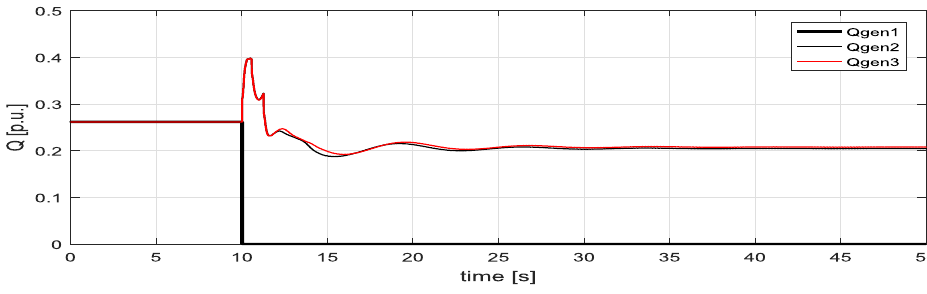
Figure 14. Time evolution of reactive powers (Qgen) of the three generators.